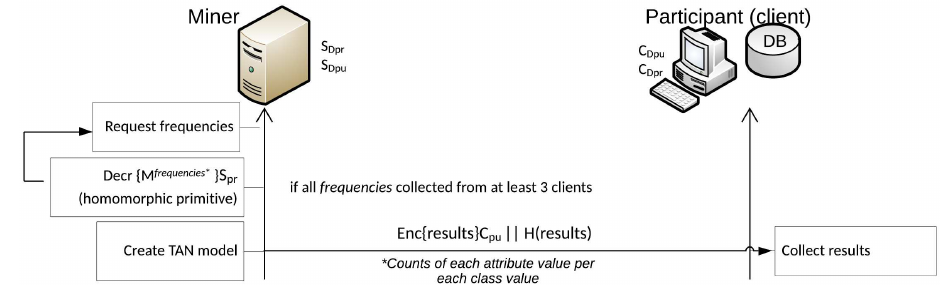
Figure 6. TAN classifier creation and final results